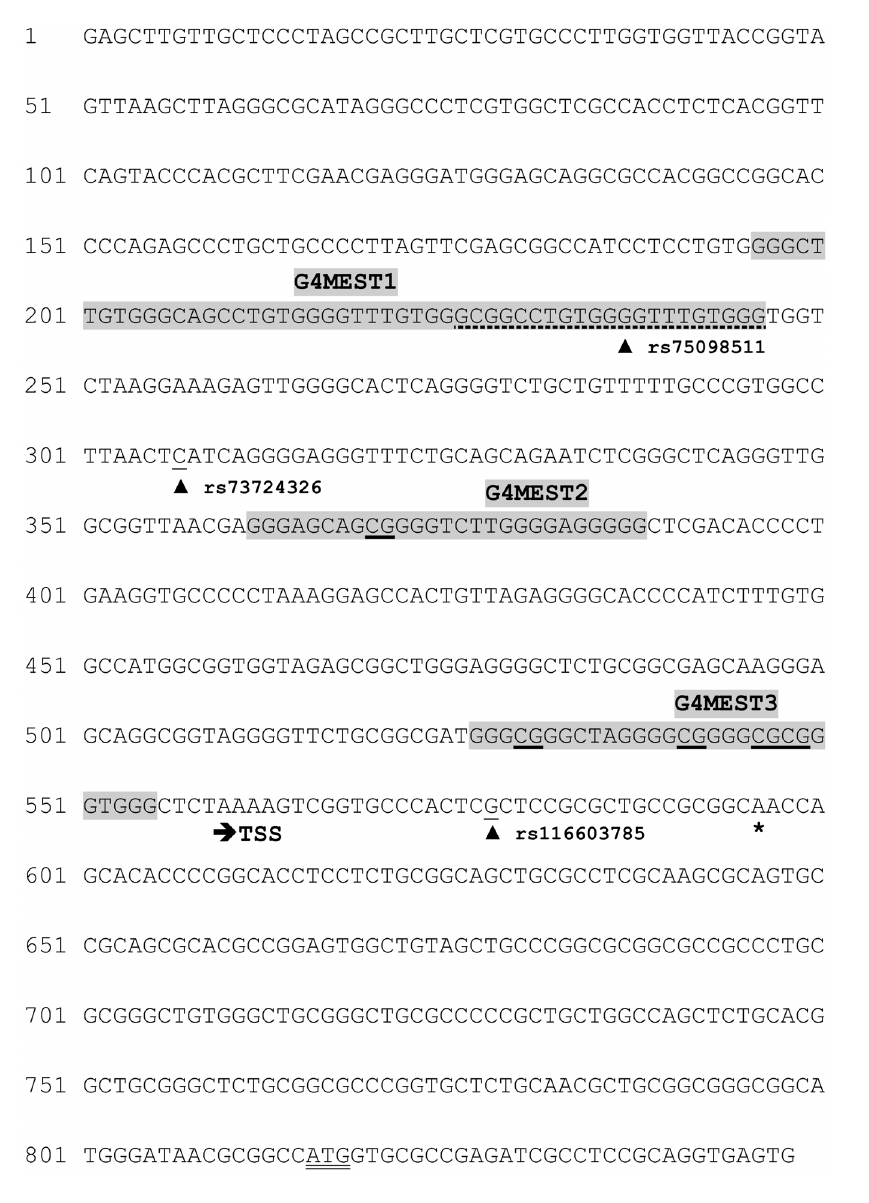
Figure 1. Sequence of MEST promoter region indicating key features. This figure encompasses the hg19 coordinates chr7:130131340-130132187. Features indicated are the three G4s (grey shading, with the extended G4MEST1L region indicated by a dashed underline), the three SNPs (arrowheads with rs IDs as indicated), CpG dinucleotides within the G4 regions (underlined), and the transcription start site (TSS, arrowed) and start codon (double underline) for the imprinted isoform of MEST (NM_001253900). The most 5 9 base of the 381bp region studied by Bunyan et al . (2011)[37] is indicated by an